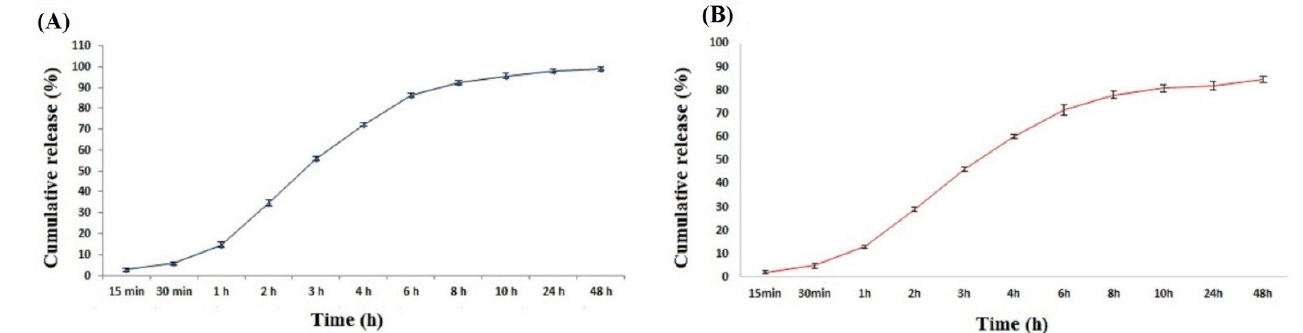
Figure 12. Release profiles of TCH in PVA/GT/TCH nanofiber ( A ) and PVA/GT/GO/TCH nanofiber ( B ) at pH 7.4. Reproduced with permission from ref [234]. Copyright 2020 Elsevier. ( B ) at pH 7.4. Reproduced with permission from ref [234]. Copyright 2020